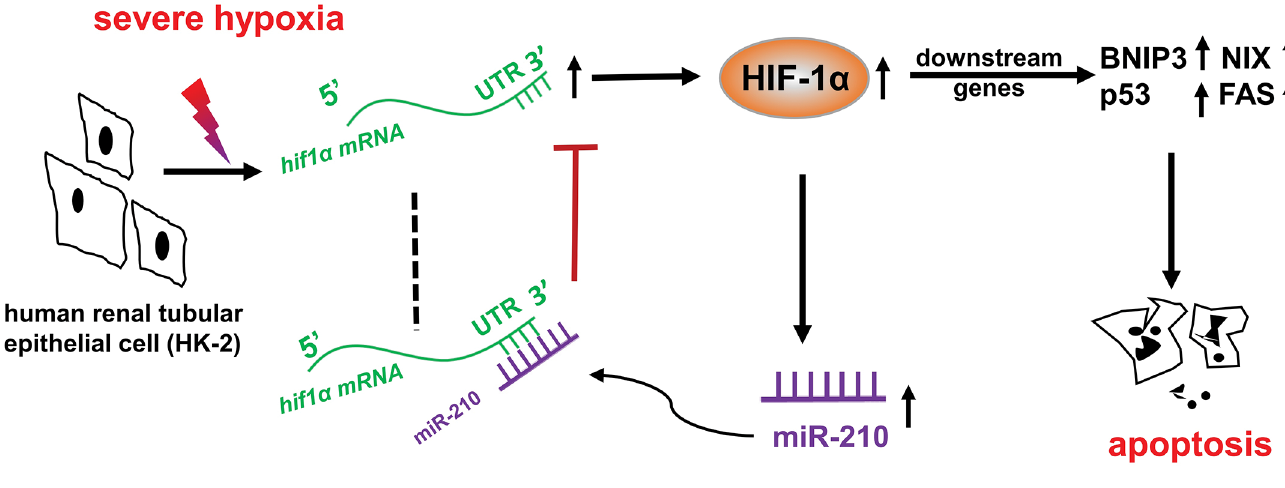
Figure 8. Schematic diagram of the negative feedback loop involving miR-210 and HIF-1 α in renal tubular cells under severe hypoxic